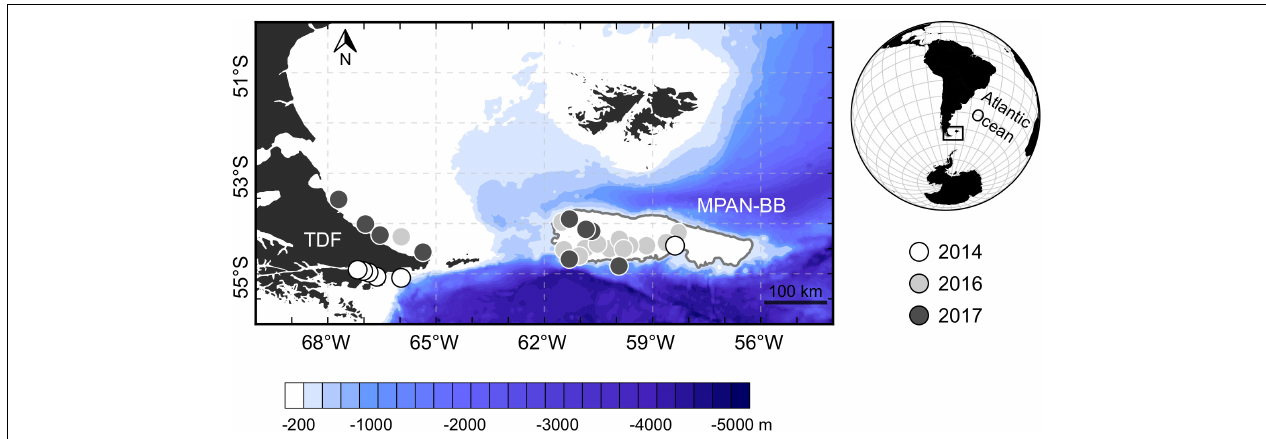
FIGURE 1 | Location of the studied habitats in the Southwest Atlantic Ocean: Tierra del Fuego (TDF) and the Marine Protected Area Namuncurá-Burdwood Bank (MPAN-BB). Stations from which Fuegian sprat Sprattus fuegensis where collected for analyzes are indicated according to the year sampled. The MPAN-BB is delimited by a gray solid line. Bathymetry from ETOPO1 Global Relief Model (Amante and Eakins, 2009).